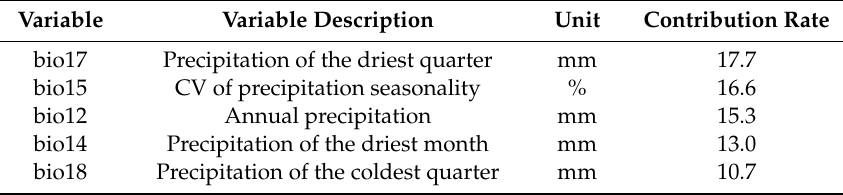
Table 1. Contribution of the 15 BIOCLIM variables in the MaxEnt modeling (%).